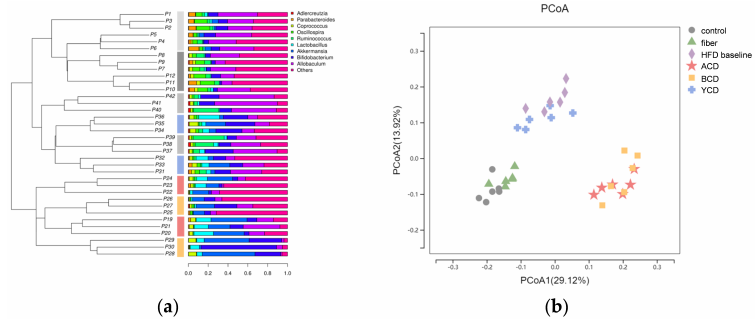
Figure 9. α -CD and β -CD supplementation resulted in inconsistent changes in gut microbial structure. Figure 9. α‐ CD and β‐ CD supplementation resulted in inconsistent changes in gut microbial struc ‐ ( a ) Unweighted pair-group method with arithmetic means cluster tree; ( b ) principal co-ordinate ture. ( a ) Unweighted pair ‐ group method with arithmetic means cluster tree; ( b ) principal co ‐ ordi ‐ nate analysis, n = 6. Control, low ‐ fat diet; HFD baseline, high ‐ fat diet without cellulose; fiber, high ‐ analysis, n = 6. Control, low-fat diet; HFD baseline, high-fat diet without cellulose; fiber, high-fat diet; fat diet; ACD, high ‐ fat diet that replaced α‐ CD with cellulose; BCD, high ‐ fat diet that replaced β‐ ACD, high-fat diet that replaced α -CD with cellulose; BCD, high-fat diet that replaced β -CD with CD with cellulose; YCD, high ‐ fat diet that replaced γ‐ CD with cellulose. cellulose; YCD, high-fat diet that replaced γ -CD with cellulose.